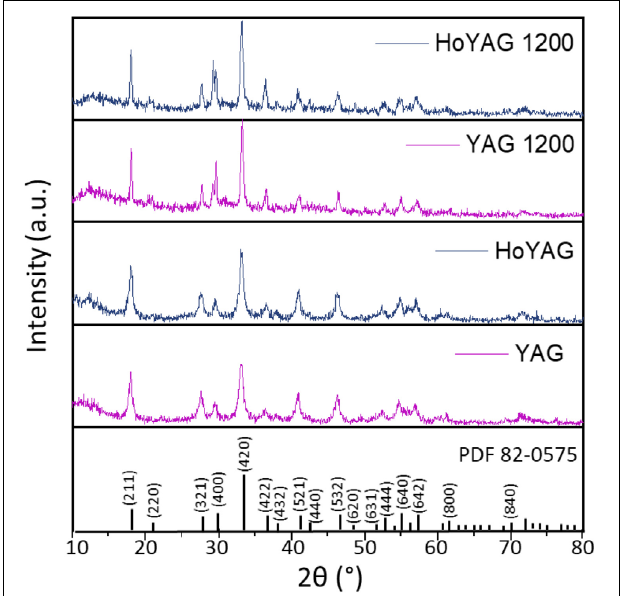
FIGURE 1 | XRD patterns of YAG and HoYAG samples as-synthesized and annealed at 1200 ◦ C. The standard XRD pattern of YAG structure is included (PDF card number 82-0575 or ICSD: